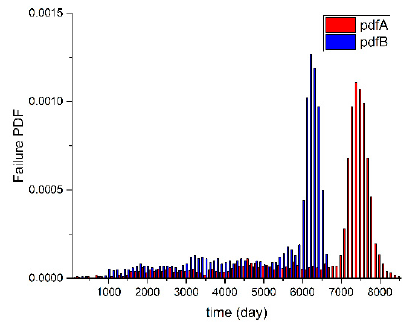
Figure 13. Failure PDF of Sat. A and Sat. B.